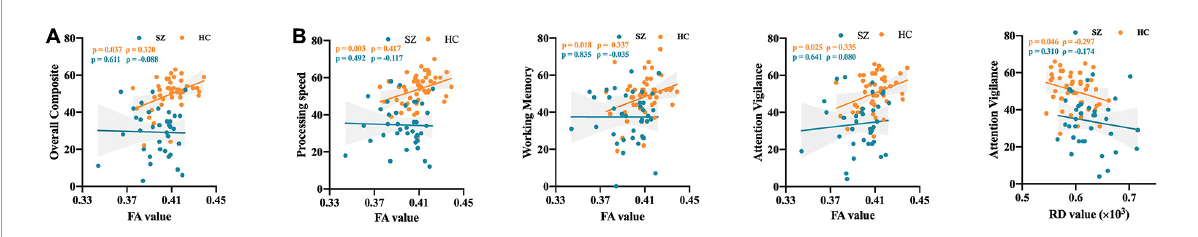
FIGURE2 The correlation between altered diffusion features and cognitive assessments. (A) The correlation between altered diffusion features and overall composite. (B) The correlation between altered diffusion features and different cognitive domain. SZ, schizophrenia; HC, healthy controls; FA, fractional anisotropy; RD, radial